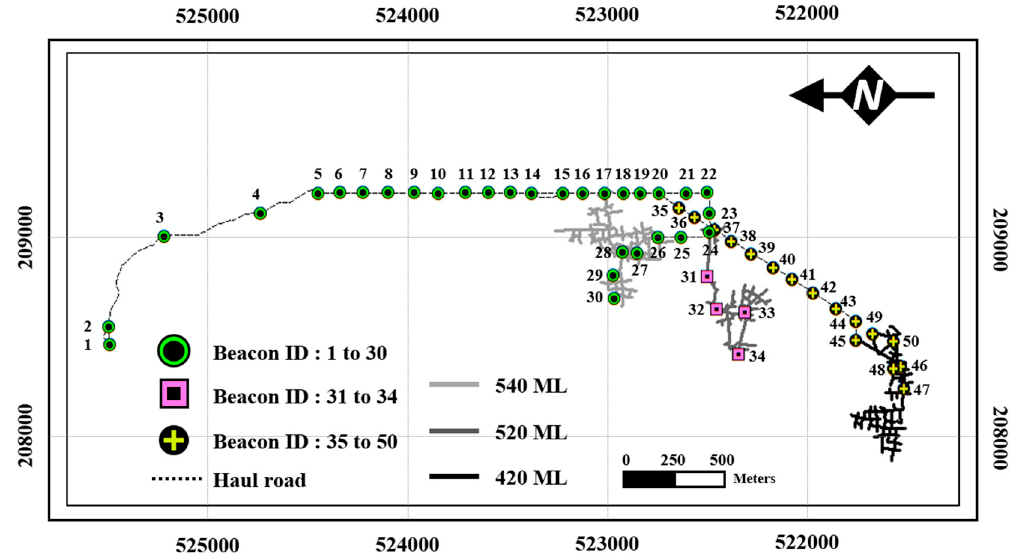
Figure 5. Underground mine map showing the installation position of Bluetooth beacons.